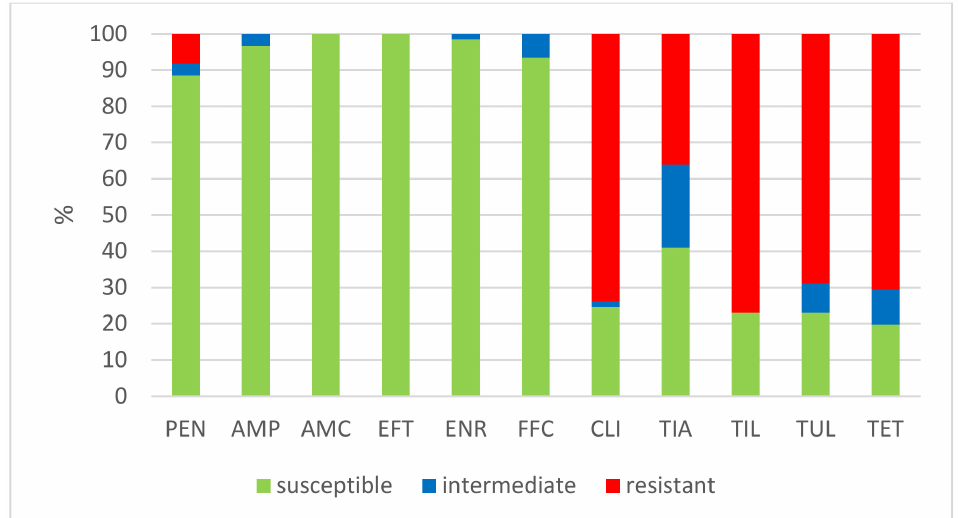
Figure 3. The percentage of susceptible, intermediately resistant, and resistant S. suis isolates from nasal swabs and tonsils. ( n = 61). PEN = Penicillin; AMP = Ampicillin; AMC = Amoxi- cillin/Clavulanate 2/1; EFT = Ceftiofur; ENR = Enrofloxacin; FFC = Florfenicol; TET = Tetracycline; STX = Trimethoprin/Sulfamethoxazole 1/19; TIA = Tiamulin; TIL = Tilmicosin; TUL = Tulathromycin; CLI = Clindamycin.